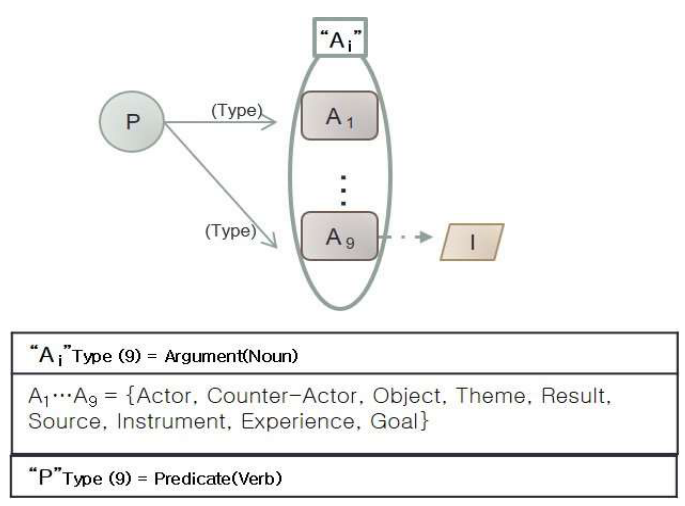
Figure 3. Visual modeling as the transformed model of refined case structure for use-case extraction.